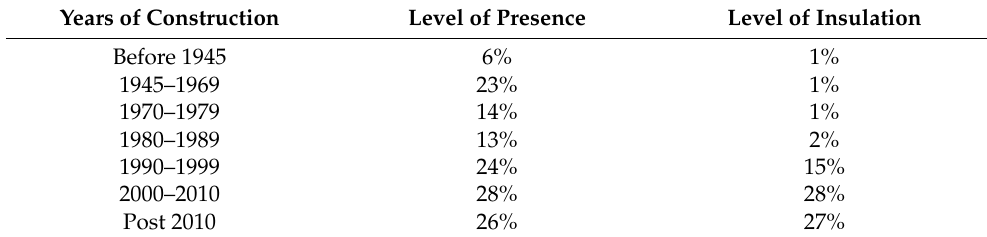
Table 2. Cavity walls (EU and